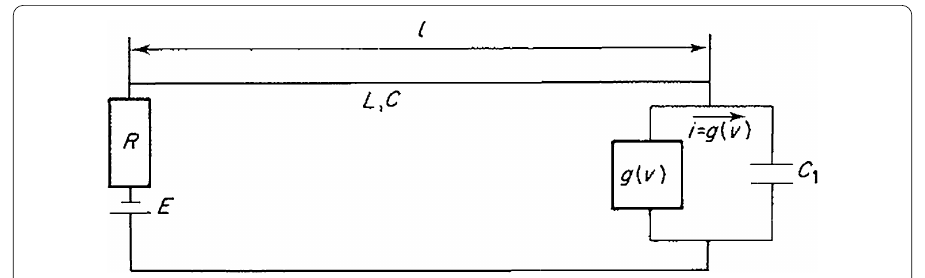
Figure 1 System with lossless transmission line